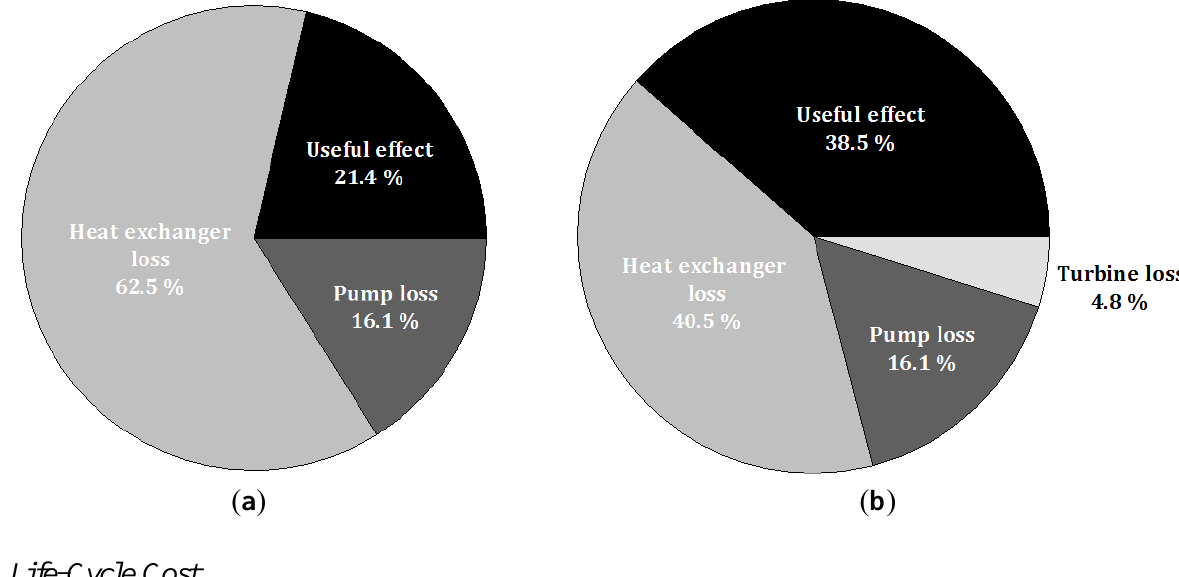
Figure 6. Exergy efficiency of each system. ( a ) System 1; ( b ) System 2.